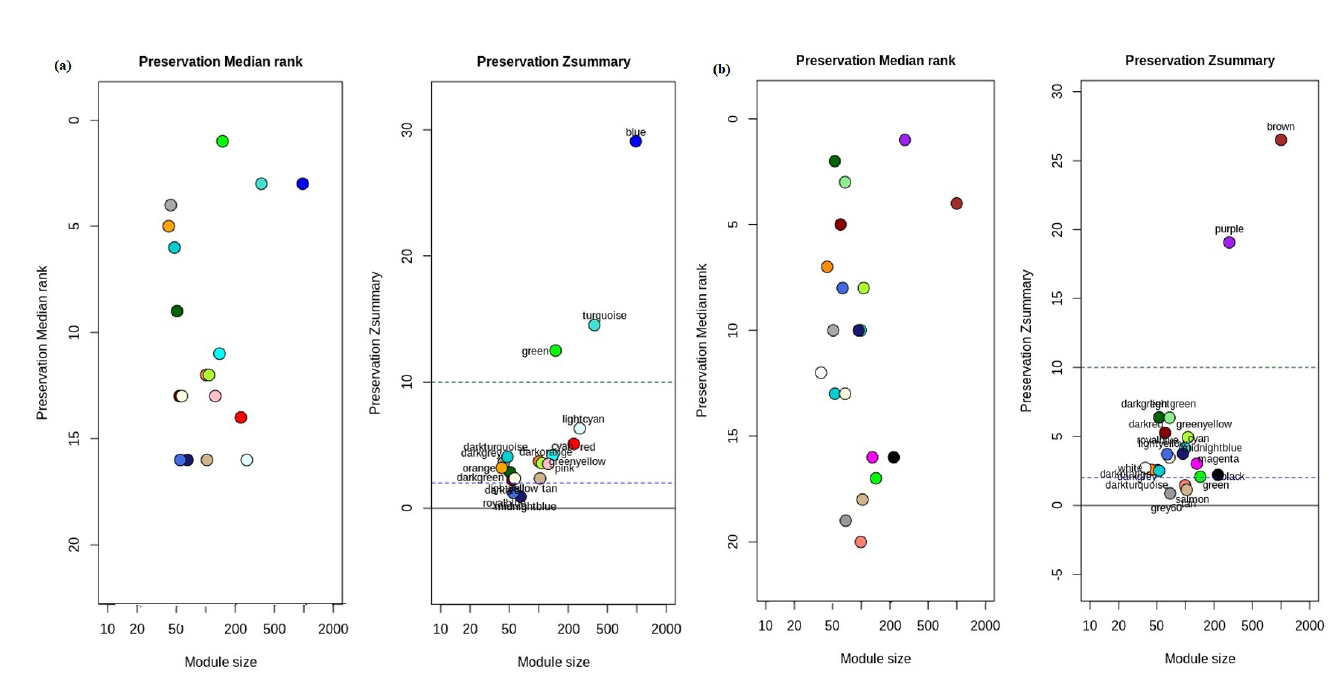
Figure 3. Preservation analysis of modules based on Z-summary and medianRank. ( a ) Identification of modules in the control condition. The modules in midnightblue and royalblue color are non-preserved. ( b ) Identification of modules in the GBC condition. The modules in tan, salmon and grey60 color are non-preserved.